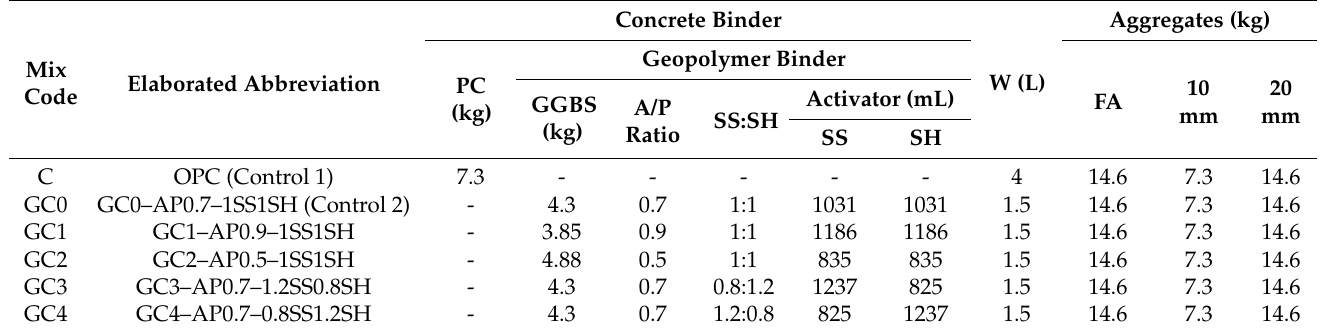
Table 4. Mix compositions of ordinary concrete (C0) and geopolymer concretes